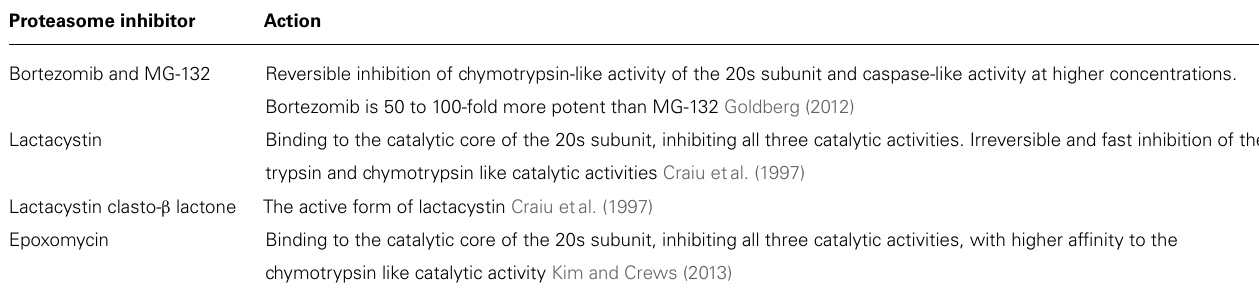
Table 2 | Proteasome inhibitors and their mechanism of action. Proteasome